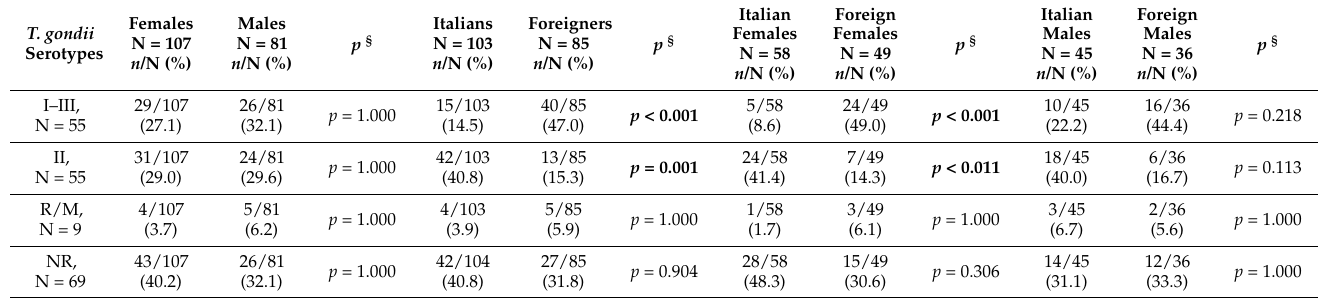
Table 1. Prevalence of Italians, foreigners, males, and females, stratified by T. gondii